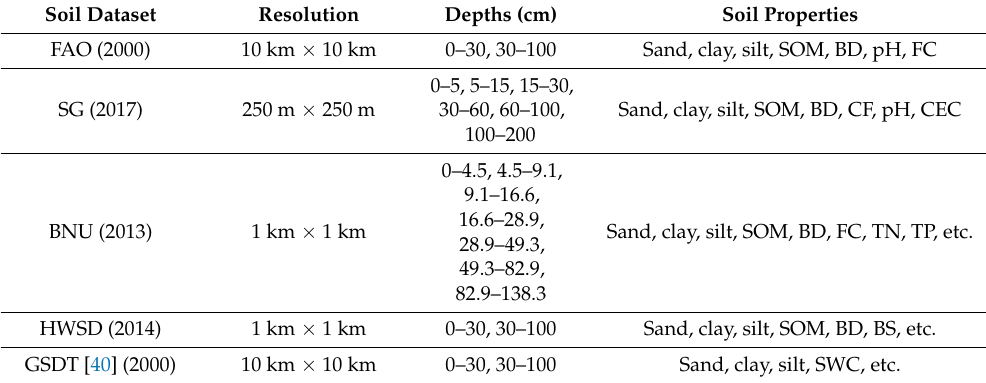
Table 1. Summary of soil datasets in China, the number in parentheses represents the publication year of the dataset: global soil data task (GSDT); coarse fragments (CF); cation exchange capacity (CEC); total nitrogen (TN); total phosphorus (TP); basic saturation (BS); saturated volumetric water content (SWC); field capacity